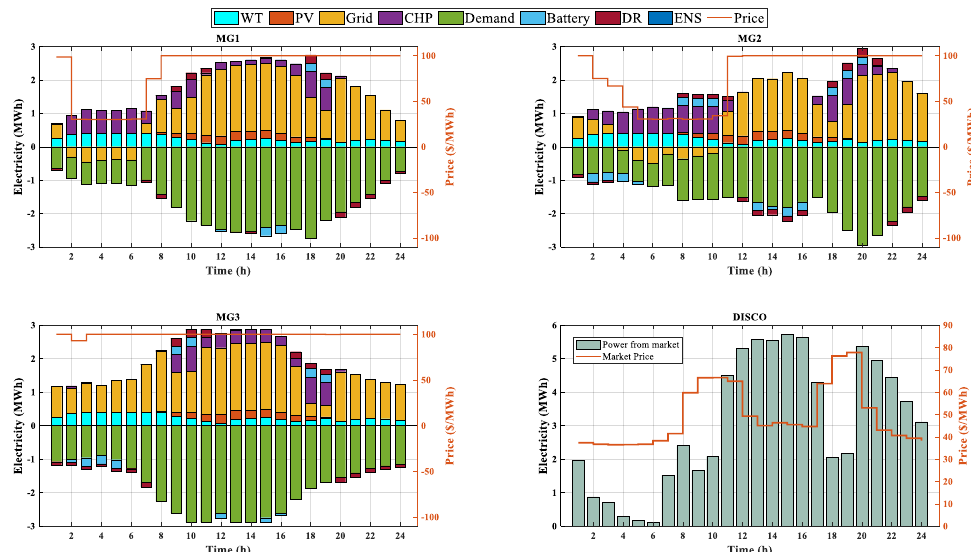
Figure 7. Optimal stochastic electricity management of MGs and DISCO.